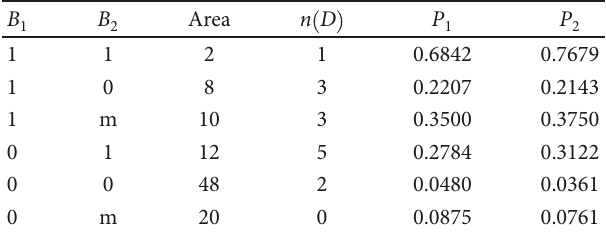
Table 1: Probabilities estimated for unique conditions in missing data variant of arti fi cial example of Schaeben ([42], Figure 1). Information on B 2 was assumed to be missing (m in column 2) for 30% of the area on the left side of the study area for this example. Area, n D , P 1 , and P 2 as in Table 4.